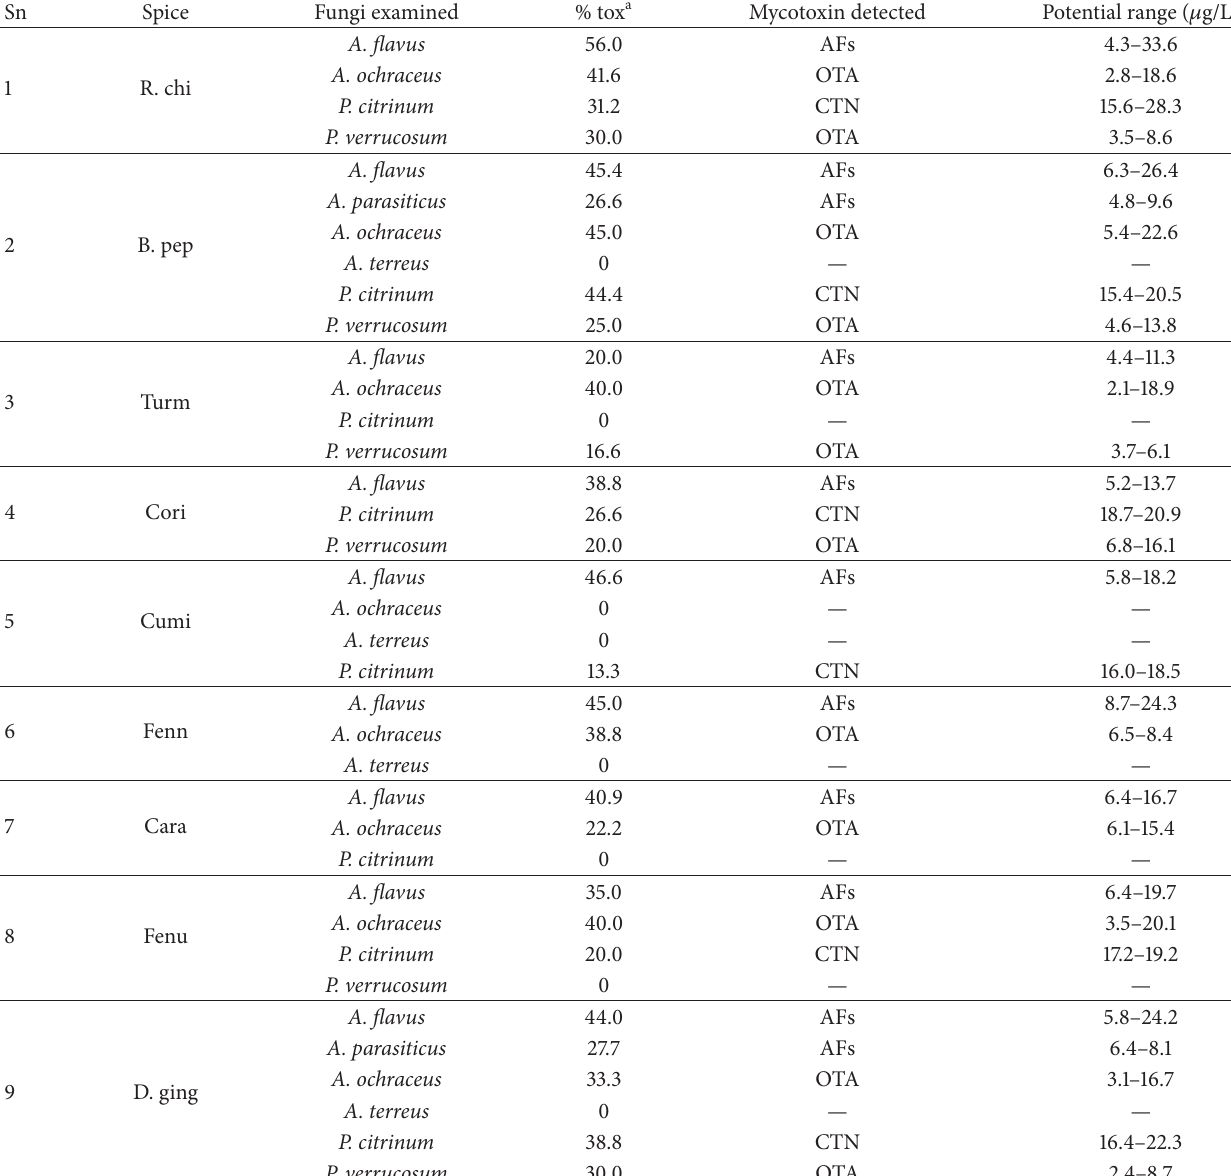
Table 2: Mycotoxin producing potentiality of toxigenic fungi from different spices.